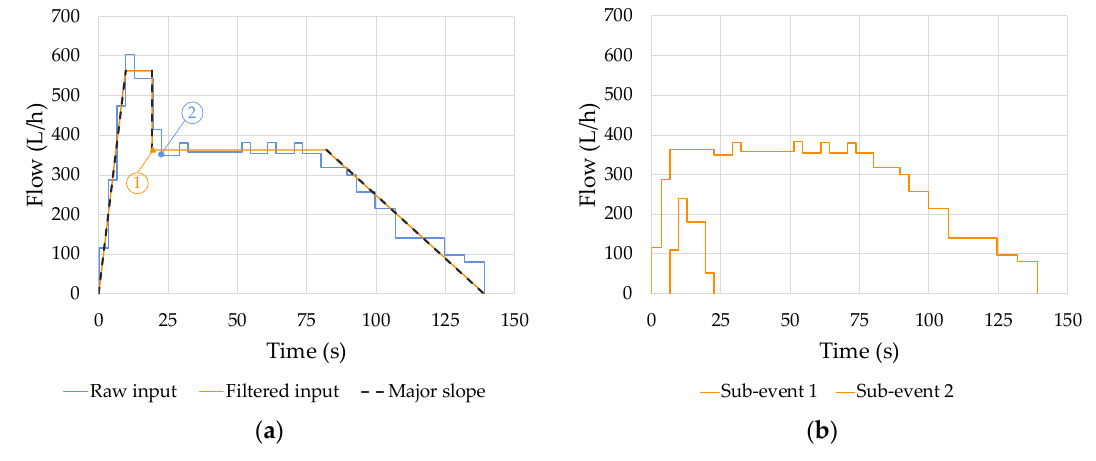
Figure 5. ( a ) Overlapped event in which the two subevents start at the same time. ( b ) Two resulting single ‐ use events after the cropping operation.